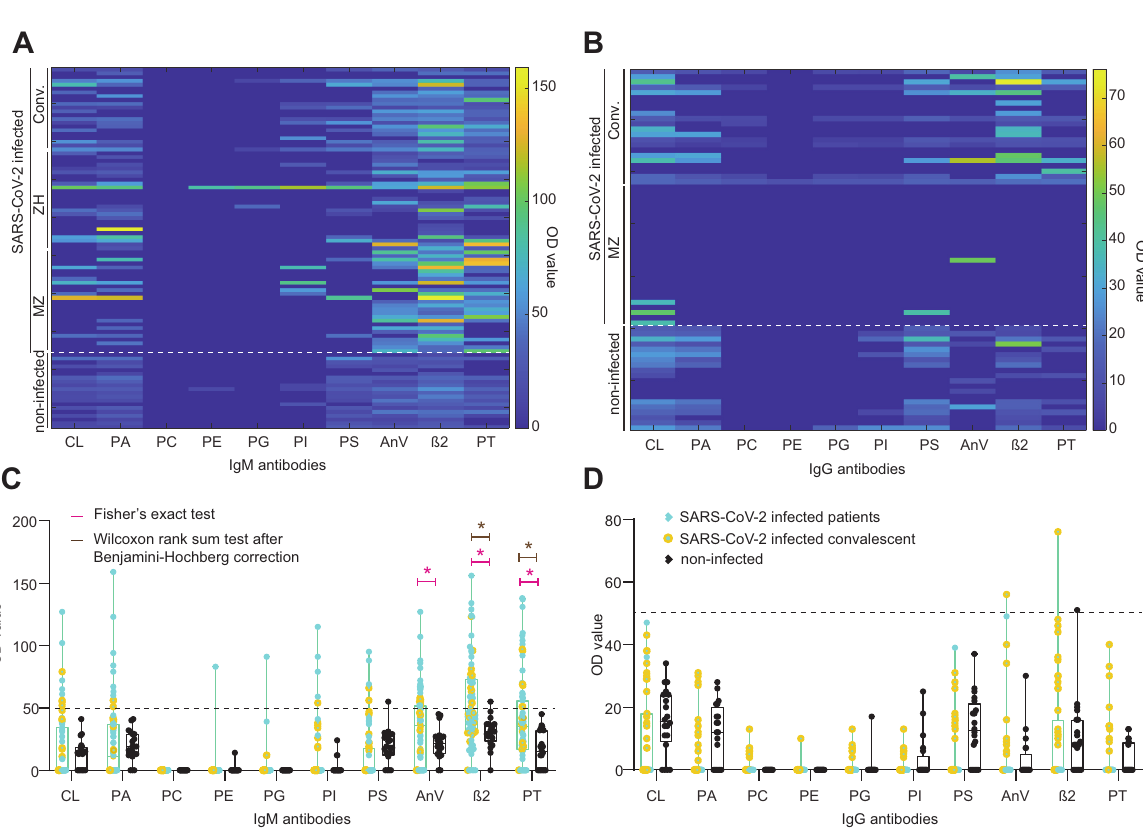
Fig 1. Heatmaps and boxplots for IgM and IgG aPL. A . and B . Colour-coded representation of IgM (A) and IgG (B) aPL. Higher OD values are evident for AnV, β 2, and PT IgM aPL. C . and D . Boxplot rep-resentation of IgM (C) and IgG (D) aPL. Dotted line: OD value 50, a cutoff determined previously by calculating the 99 th percentile of 150 apparently healthy individuals (Roggenbuck et al ., 2016; Nalli et al ., 2018). Pink star: statistically significant distributional differences between non-infected controls and SARS-CoV-2 infected individuals according to Fisher’s exact test. Brown star: statistically significant distributional differences between non-infected controls and SARS-CoV-2 infected individuals according to Wilcoxon rank sum test after Benjamini-Hochberg correction. Black dots: Non-infected controls. Turquoise dots: SARS-CoV-2 infected hospital patients. Yellow dots: SARS-CoV-2 infected convalescent